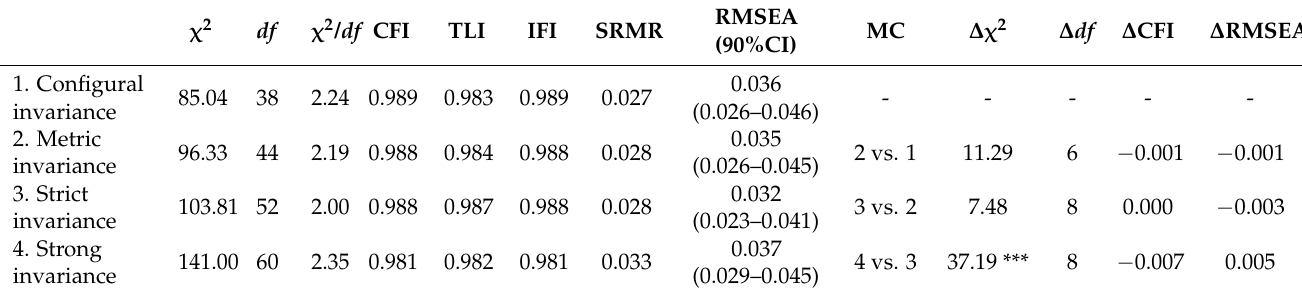
Table 2. Measurement invariance across gender.